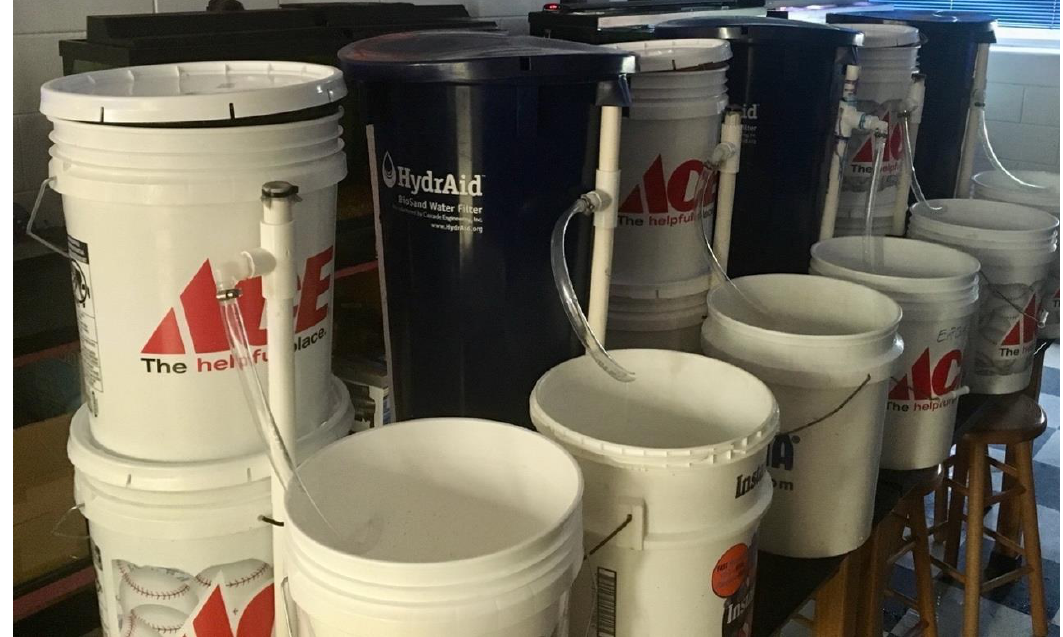
Figure 3. Two bucket BSFS and HydrAID commercial BSFs in the high school laboratory.